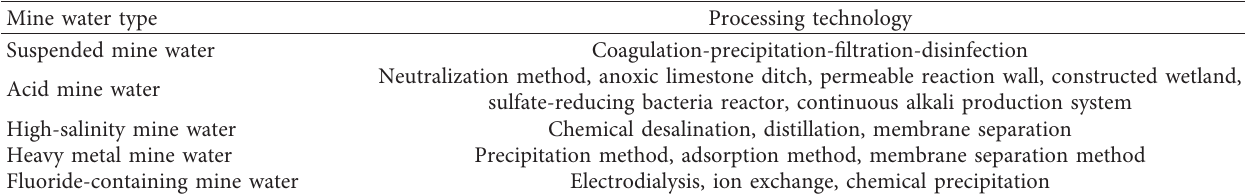
Table 1: Mine water treatment